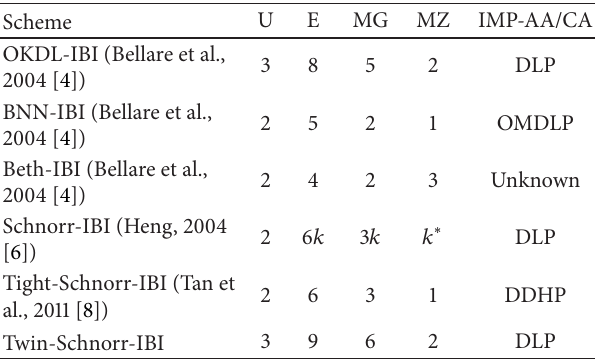
Table 2: Comparison of the identification protocol with other discrete logarithm IBI